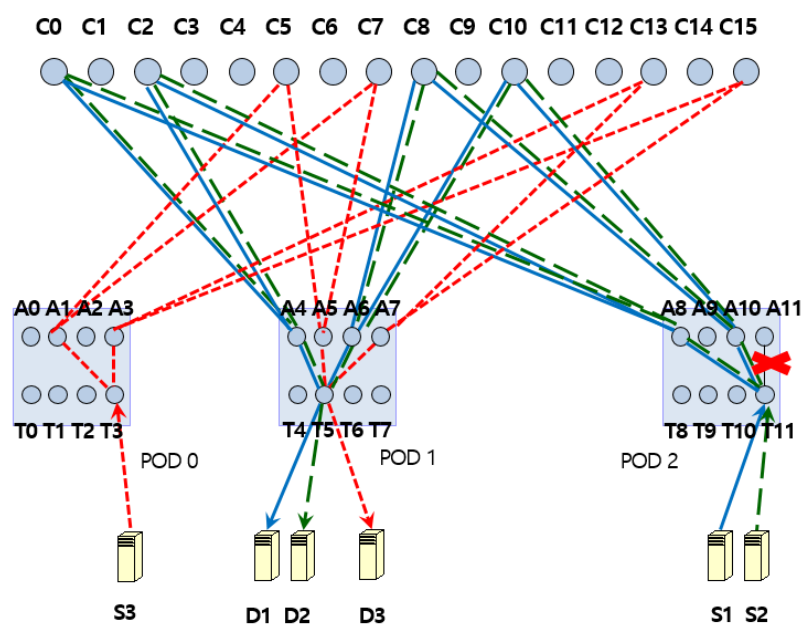
Figure 3. Illustration of LBSP (Load-Balancing based on Symmetric Path groups) selecting an alternative path group when a failure occurs on the link between aggregation Switch A11 and ToR Switch T11.